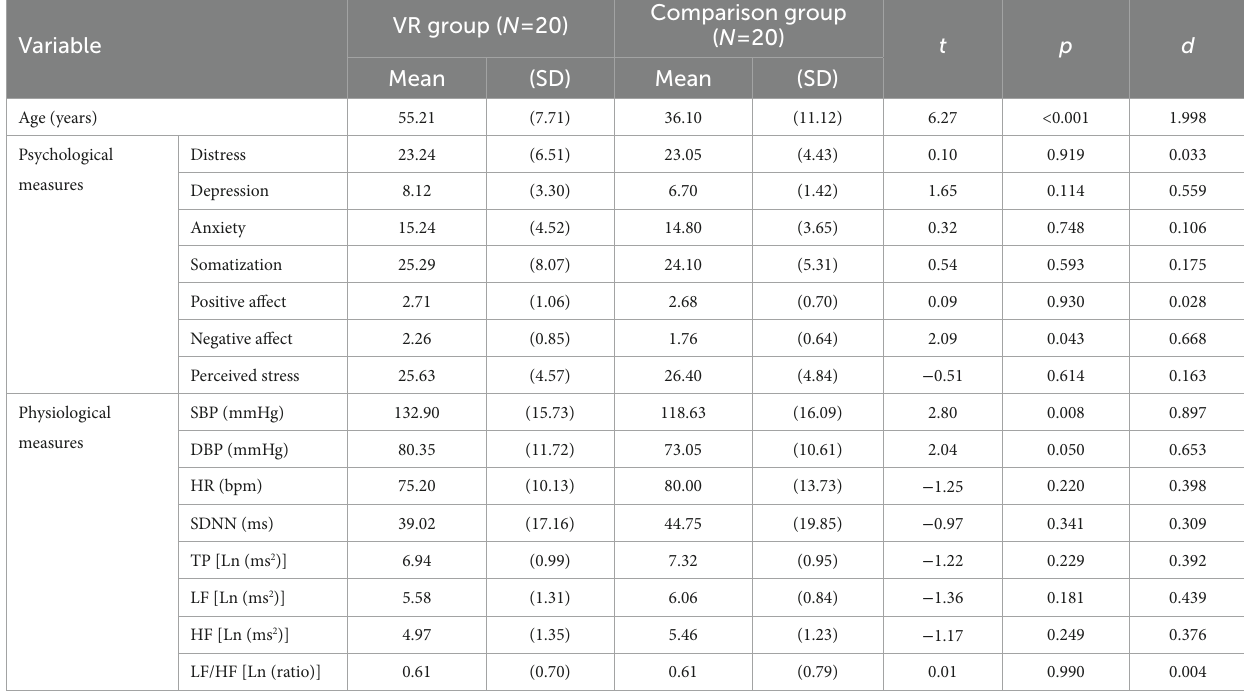
TABLE 2 Participants’ stress-related outcomes at the